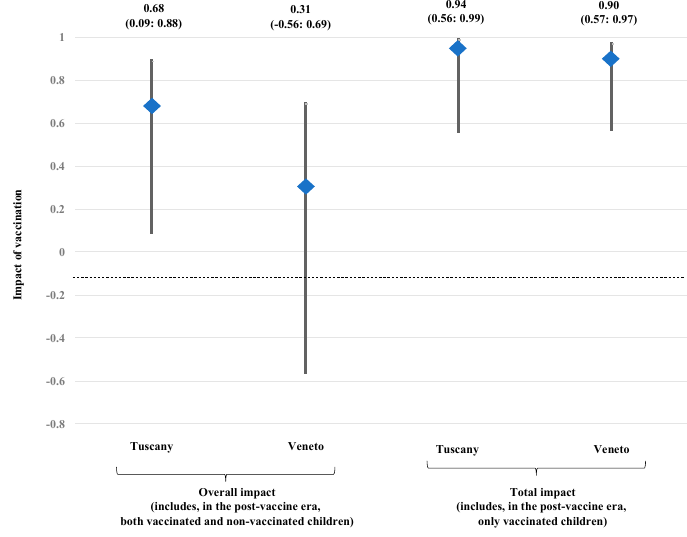
Figure 2. Impact of vaccination schedule in Tuscany and Veneto. Impact was evaluated as overall impact (including, in the post-4CMenB era, both vaccinated and not vaccinated children) and as total impact (including, in the post-4CMenB era, only vaccinated children).